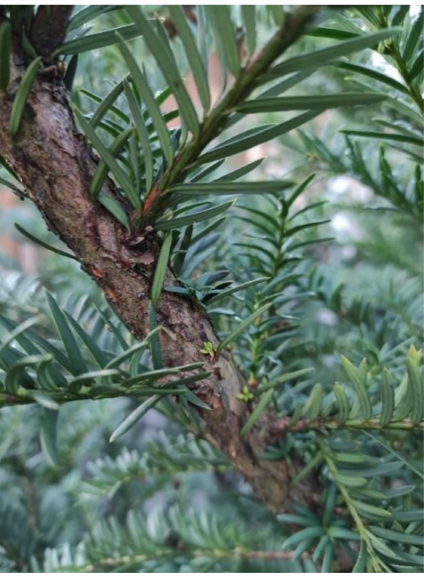
Figure 3. A branch of a yew; paclitaxel is isolated from the bark, needles, or whole branches of